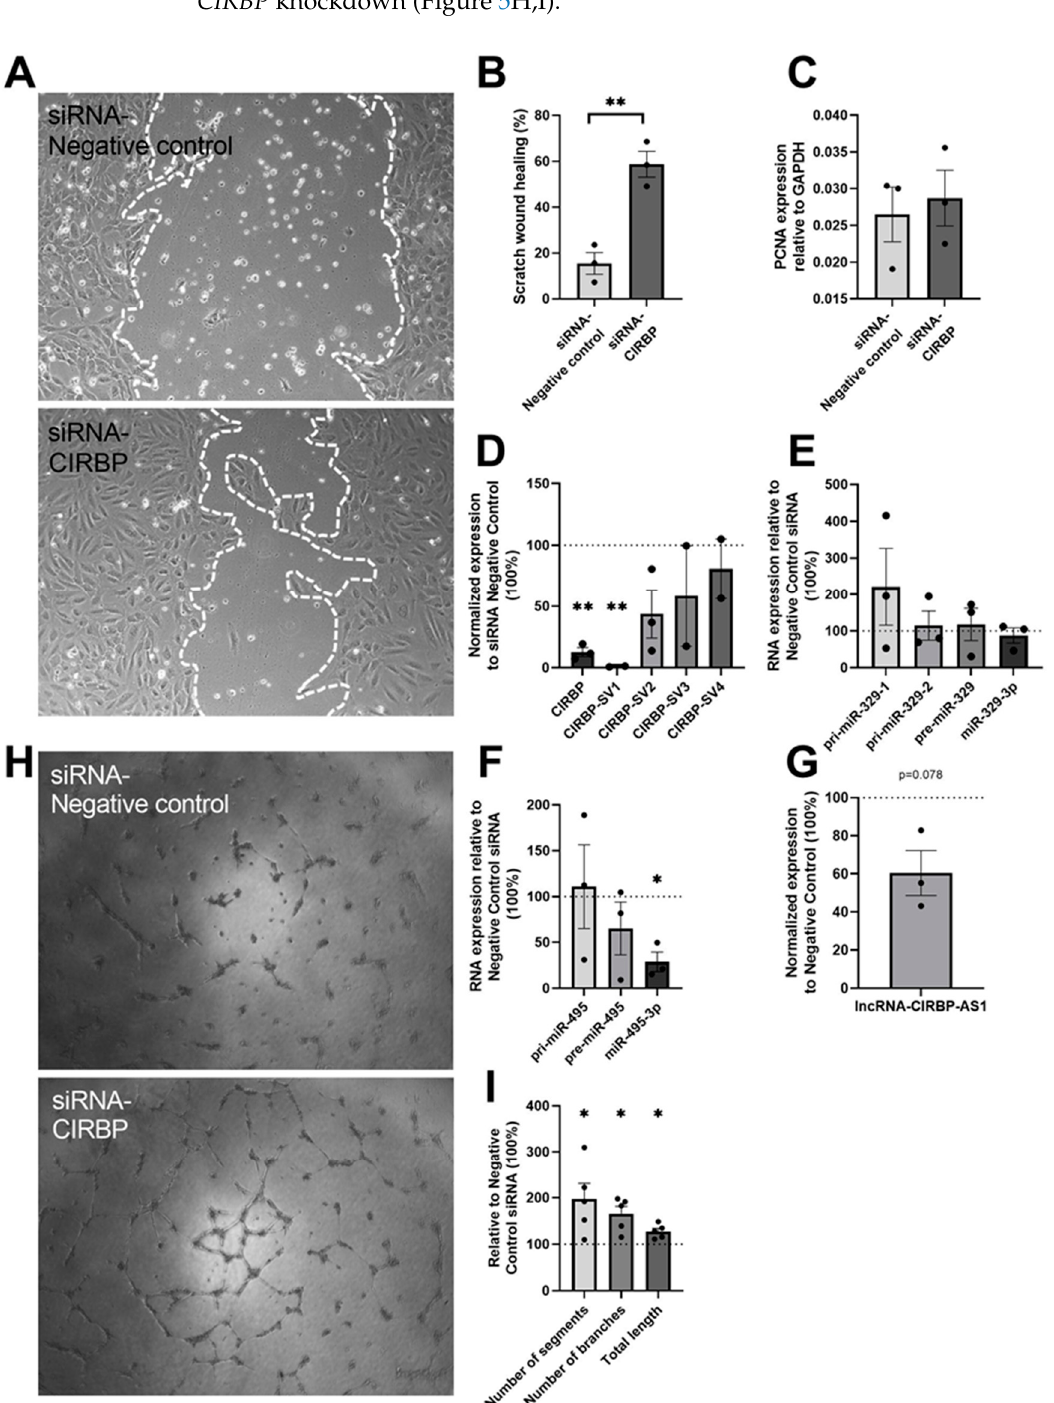
Figure 5. siRNA- CIRBP transfection for 24 h in HUVECs: ( A ) Representative images of wound healing ( n = 3) and ( B ) quantification of the migration area treated with siRNA targeted to CIRBP and negative control for 24 h. White, dotted lines mark the edge of the HUVECs’ monolayer. ( C ) Proliferating cell nuclear antigen gene ( PCNA ) expression level in HUVECs as an indicator of cell proliferation. ( D ) Expression of total CIRBP and its splice variants after scratch assay, normalized to GAPDH. CIRBP -SV3 and CIRBP -SV4 expression were below the detection limit in one out of three experiments. ( E – G ) pri-miRs, pre-miRs, and mature microRNA expression levels of miR-329 and miR-495 were measured after scratch assay and normalized to U6; lncRNA- CIRBP -AS1 expression levels were measured and normalized to GAPDH . Data show the percentage compared to the siRNA negative control group. ( H ) Representative image of the tube-formation assay ( n = 5) on HUVECs treated over 24 hours with siRNA targeted to CIRBP and negative control. ( I ) Quantification of